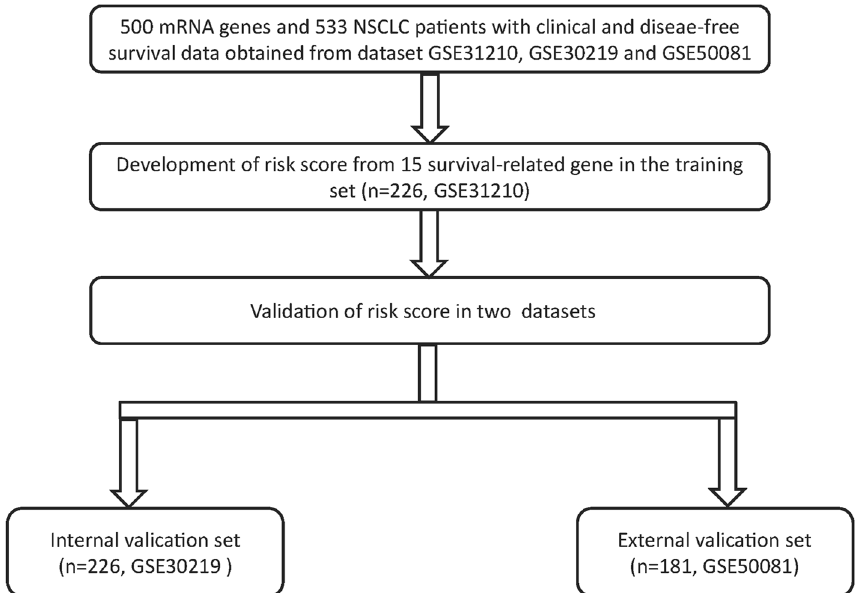
Figure 1. Development and validation of the fifteen-mRNA signature shown as study